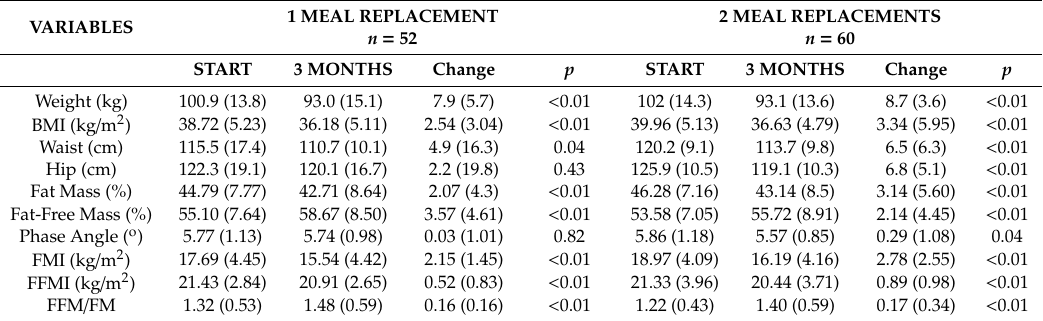
Table 3. Changes in anthropometric and body composition parameters before and after 3 months of the intervention in both groups (1 meal replacement vs. 2 meal replacements).